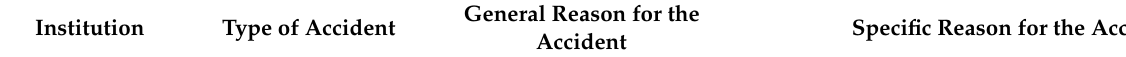
Table 3. Characteristics of students’ accidents at Technical University